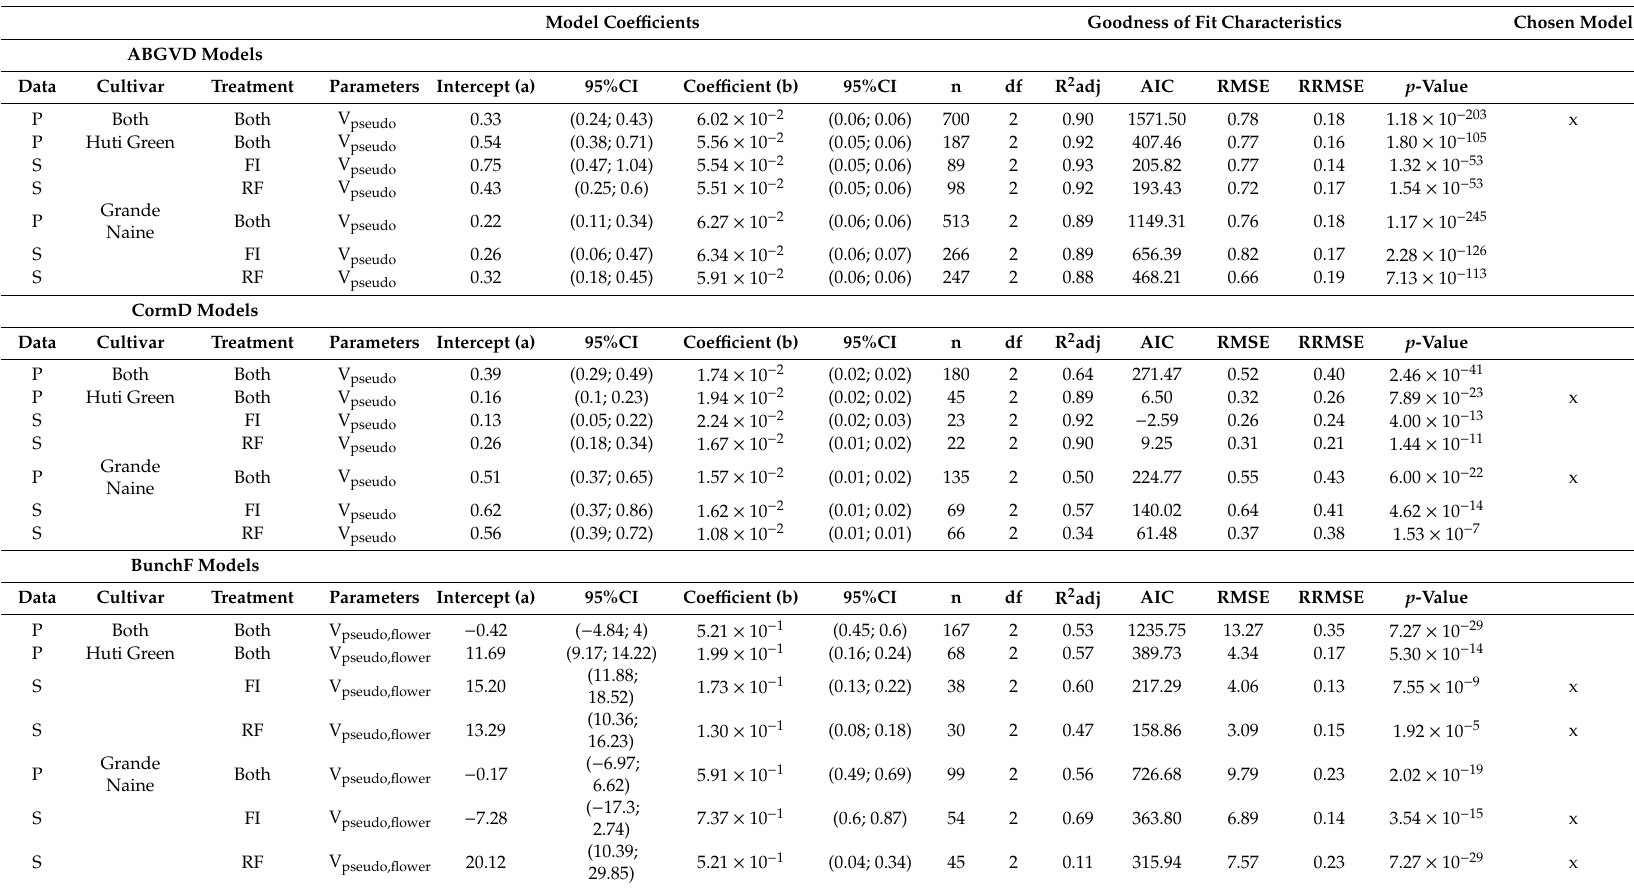
Table 5. Linear regression model comparison. ABGVD notes aboveground vegetative dry biomass, cormD notes corm dry biomass and bunchF notes bunch fresh biomass. Models are characterized by parameter x, intercept ‘a’ and slope ‘b’ as y = a + b * x. P indicates pooled model, S indicates specific model. Both indicates pooling of data across cultivars and / or treatments. FI notes full irrigation and RF notes Rainfed. V pseudo notes pseudostem volume, V pseudo,flowering , notes V pseudo at